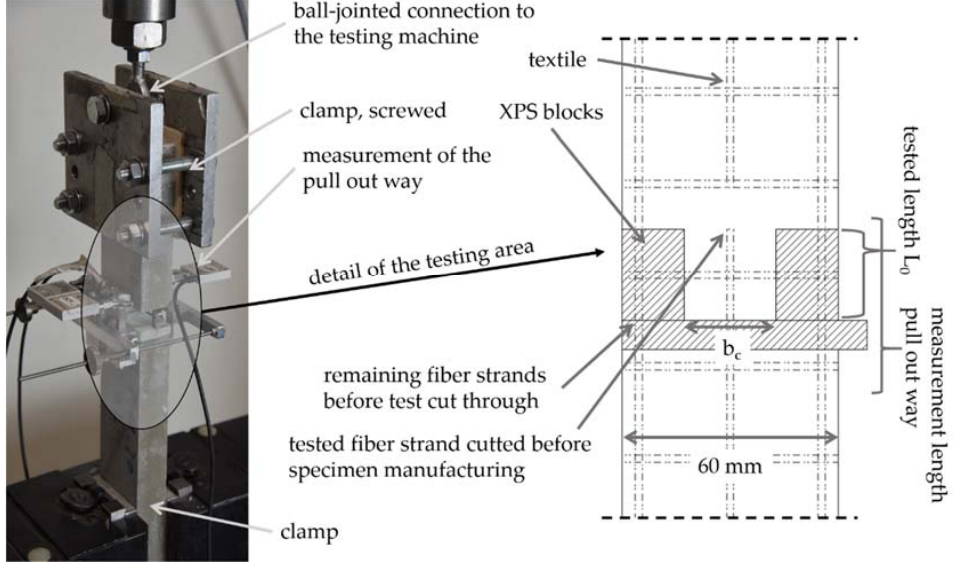
Figure 7. Test setup ( left ) and detail of the tapered area and the predetermined breaking point ( right